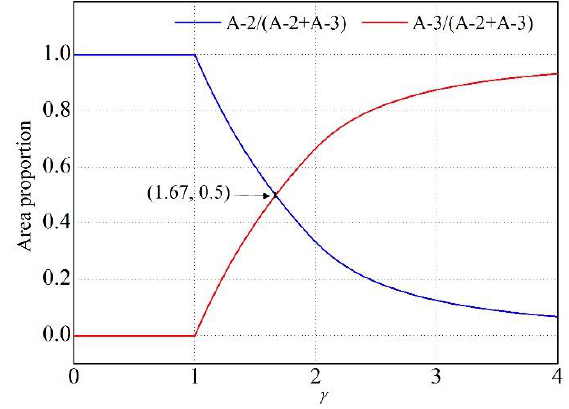
Figure 5. Area proportions of A-2 and A-3 for γ .